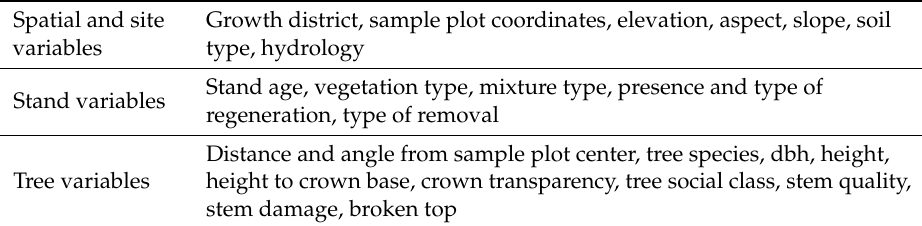
Table 1. Variables assessed in the